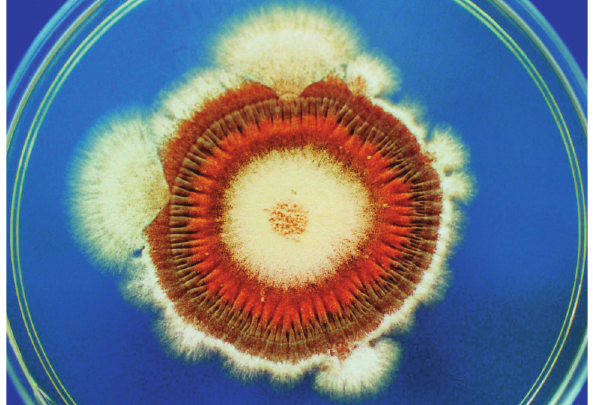
Figure 4 - Mitotic segregant with crinkled morphology produced by spon- taneous haploidization of the D1 diploid strain.